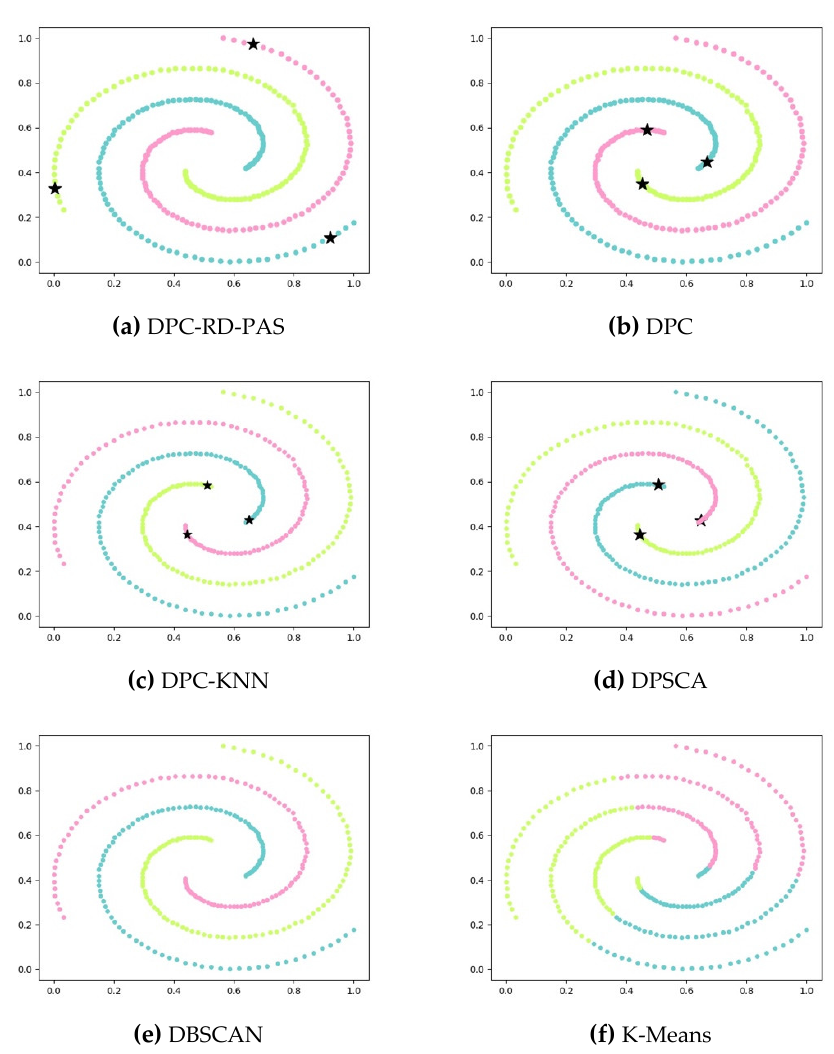
Figure 7. Clustering results on the Spiral dataset.